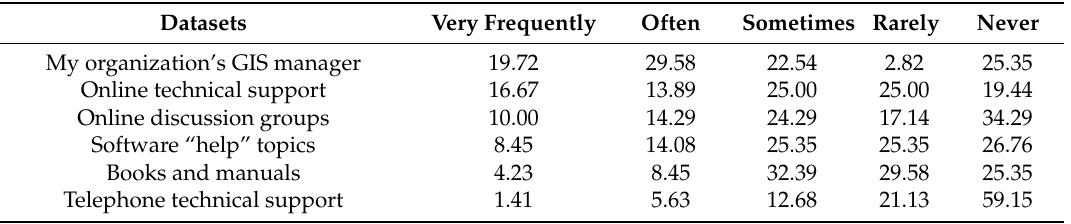
Table 7. Frequency of use (percent of respondents) of types of GIS support as indicated by recent graduates from forestry programs at Mississippi State University, Oregon State University, and